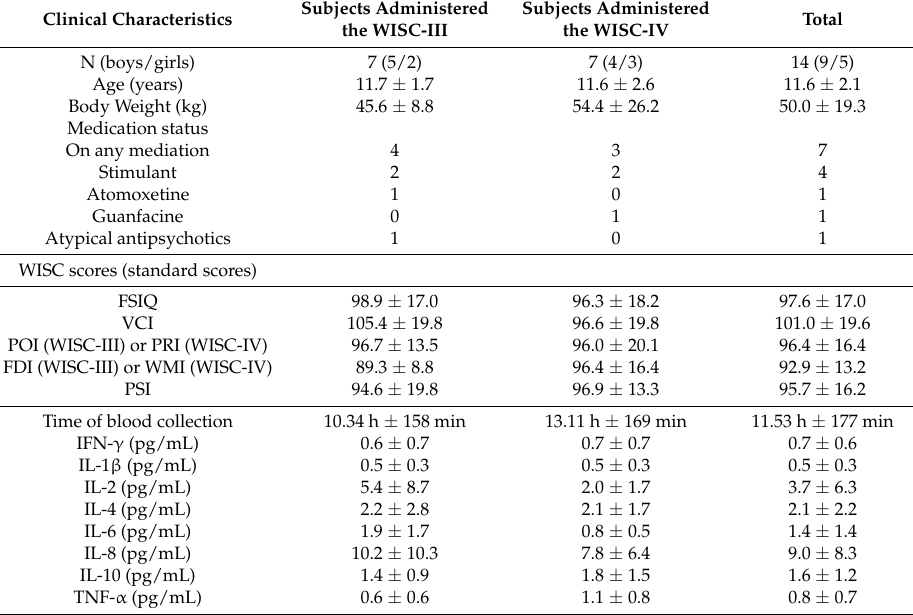
Table 1. Clinical characteristics, Wechsler Intelligence Scale for Children (WISC) scores, and cytokine